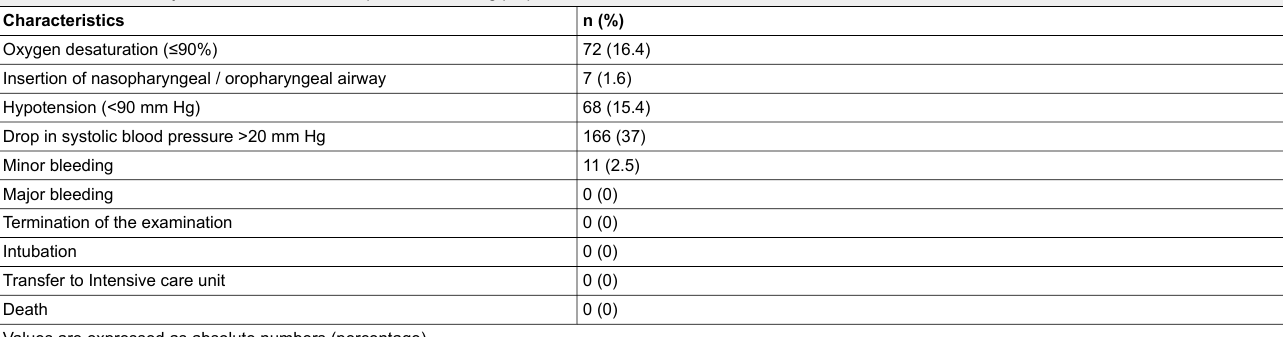
Table 5: Minor and major adverse events in 440 patients receiving propofol sedation.